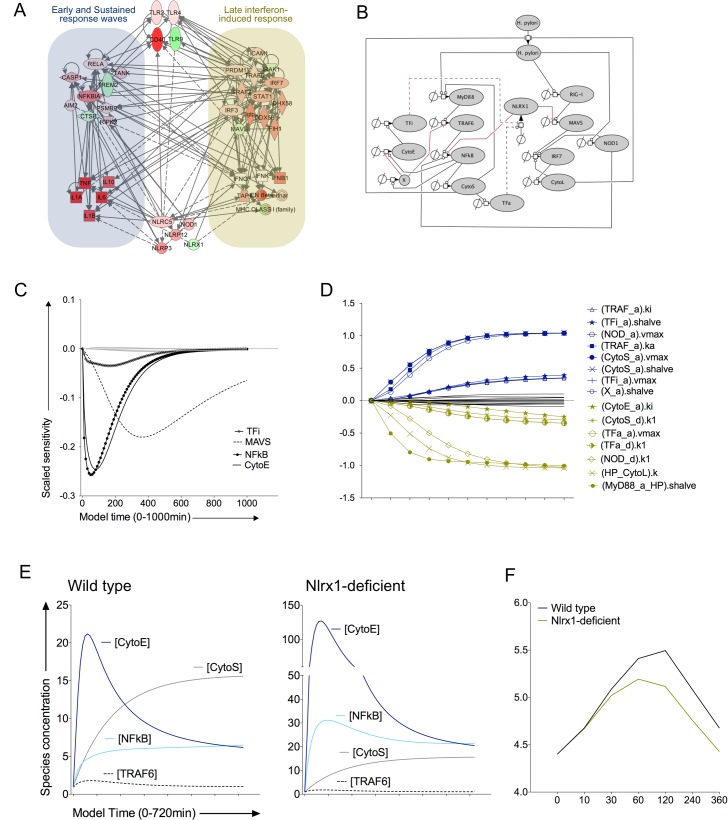
Modeling macrophage immunity to Helicobacter pylori infection reveals an essential role for NLRX1 in favoring bacterial burden.Differentially regulated genes from the RNAseq dataset were analyzed for molecular crosstalk using Ingenuity Pathway Analyzer and a preliminary interaction network was created. Red indicates increased expression whereas green indicates reduced expression at time 360 min. Molecules in white are not detected (A). Early, sustained and late wave responses were included. Feedback circuits were added to canonical pathways and a biological system was engineered in Systems Biology Mark-up Language (B). In B: red lines represent negative regulation, positive reactions are black, solid lines are experimentally validated and dashed lines are hypothetical feedback loops. Two sensitivity analyses were performed on the calibrated mathematical model: effects of model species on NLRX1 (C); and effect of NLRX1 on local parameters (D). Time course model simulations for a wild type compared to Nlrx1-deficient system demonstrate differences in NF-kB signaling (E) and H. pyori burden in silico (F).